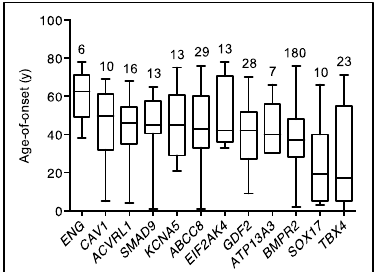
Figure 2. Age-of-disease onset for all PAH Biobank cases with rare deleterious variants in known PAH risk genes. Box plots showing median, interquartile range and min/max values for age-of-disease onset (i.e., age at diagnostic right heart catheterization). The number of cases carrying variants for each gene is given above each box plot. Genes represented by less than four cases are not shown.